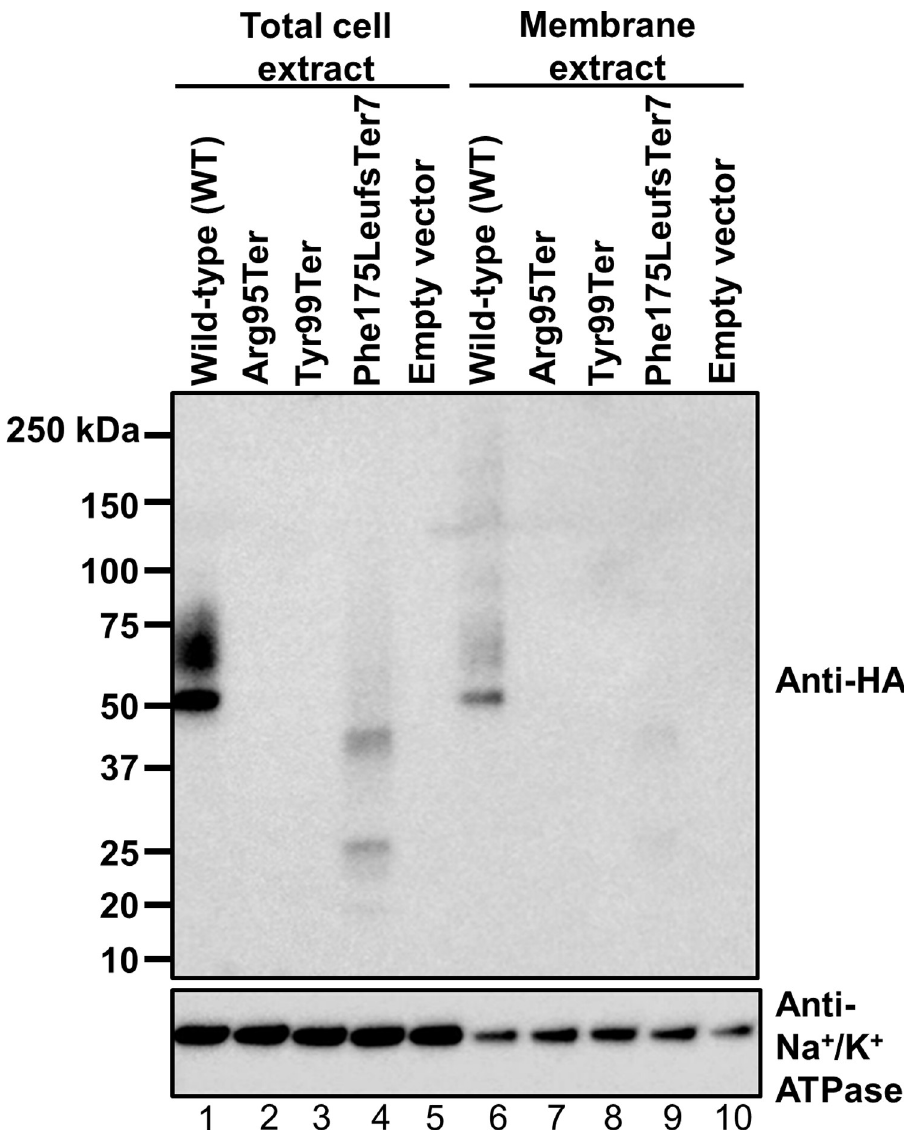
Fig 1. GPR151 variant proteins are not stably expressed. Western blot expression of HEK293 cells transfected with pcDNA3.1 plasmids encoding GPR151 variants with N-terminal HA-tag. The expected molecular weight of wild-type (WT) GPR151 is 47 kilodaltons (kDa). Na + /K + ATPase is shown as a loading